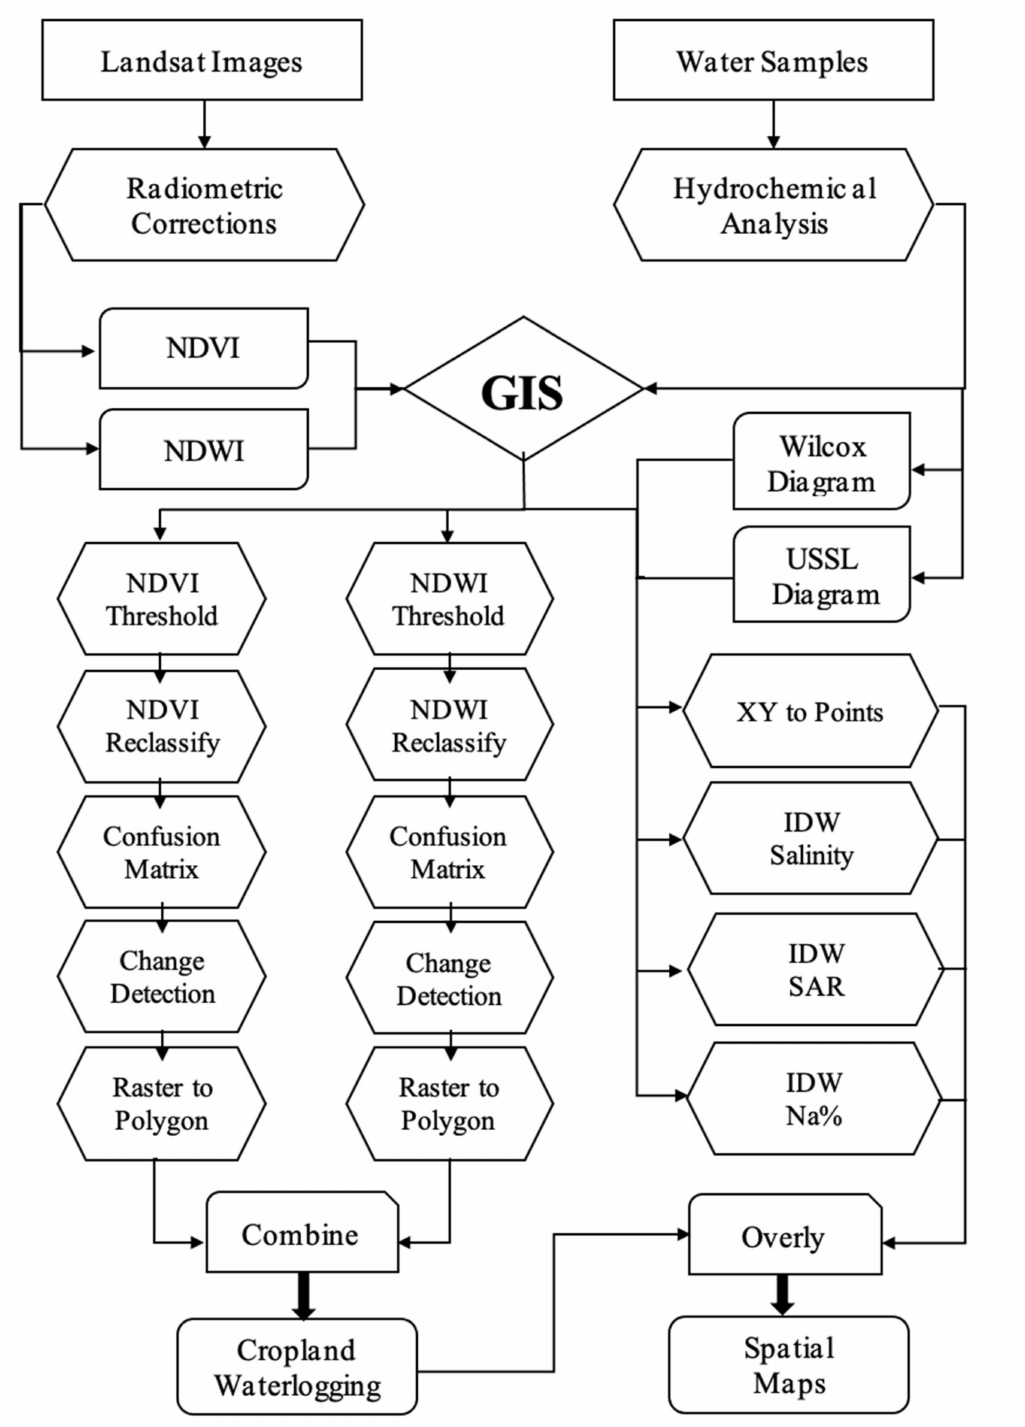
Figure 4. Schematic diagram of the research